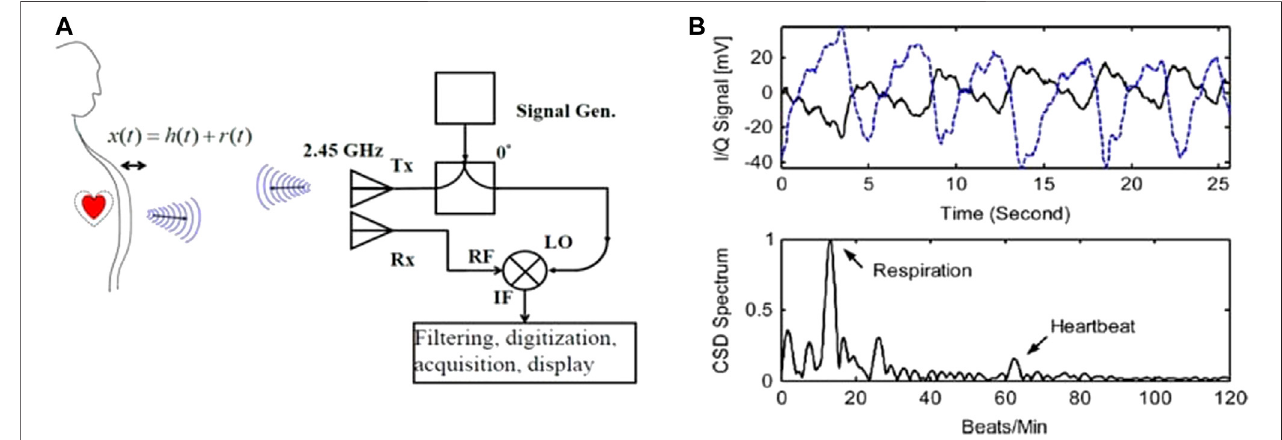
Frontiers in Communications and Networks |